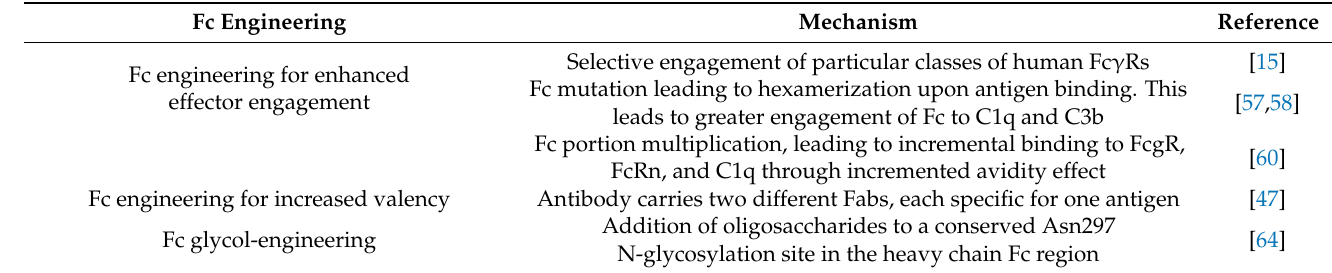
Table 1. Mechanisms of Fc engineering for therapeutic IgG1